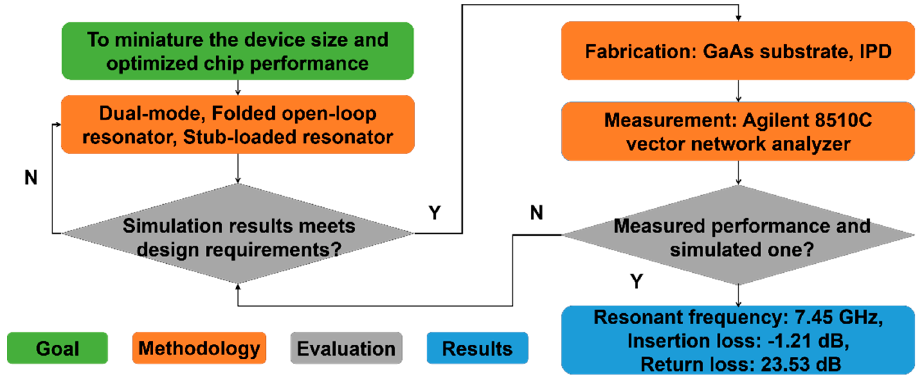
Figure 1. The flowchart of the proposed bandpass filter (BPF), including the goal, methodology, evaluation, and results.